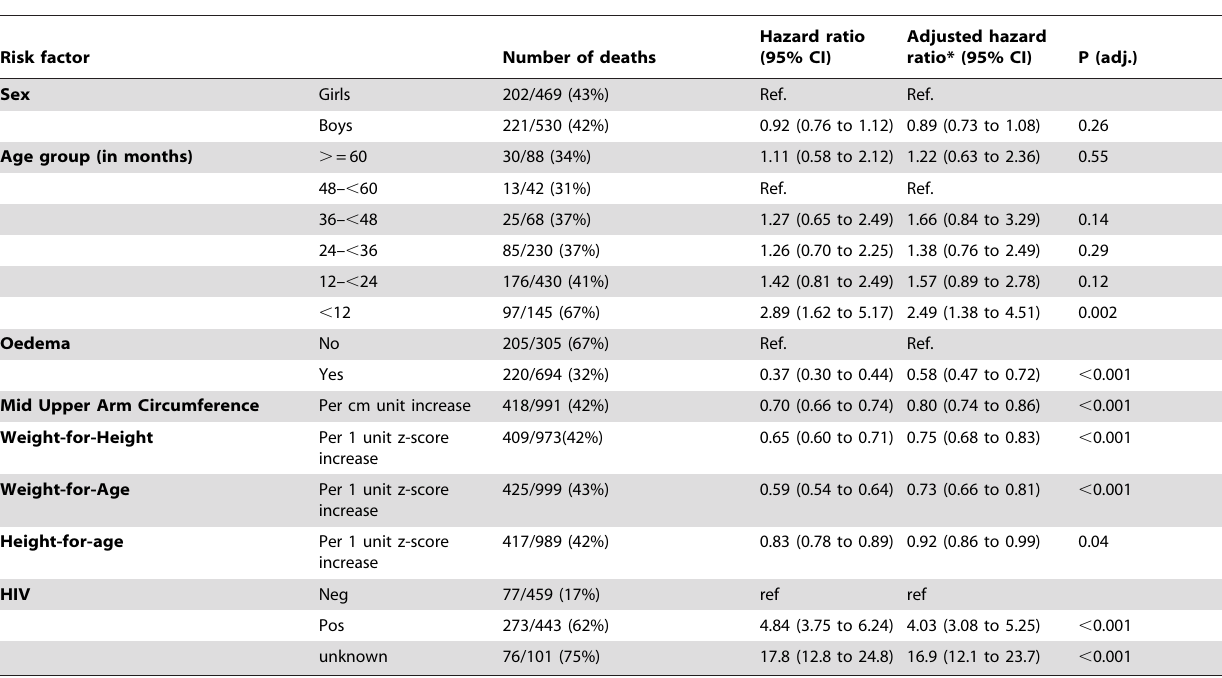
Table 2. Cox regression exploring main baseline predictors of